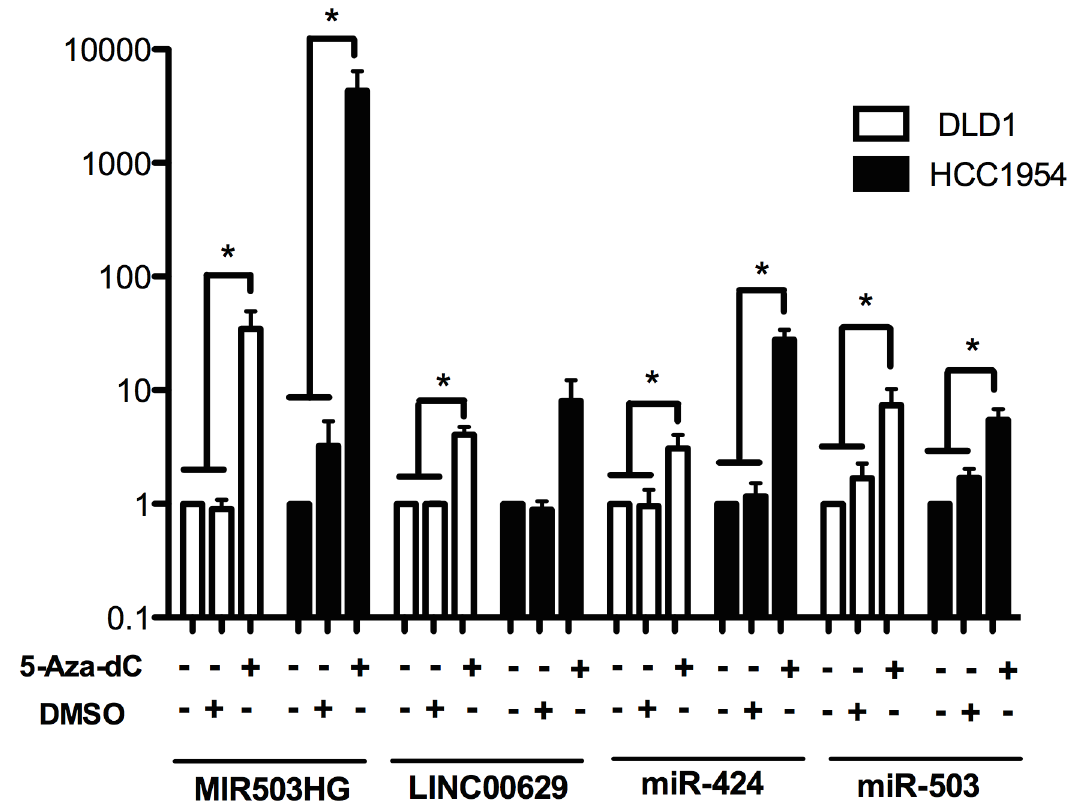
Fig 4. MIR503HG and LINC00269 expression can be regulated by methylation. Expression levels of MIR503HG , LINC00269 ,and their neighbouring miRNAs — miR-424 and miR-503, were determined in RNA samples from breast and colon adenocarcinoma cell lines treated with 5-aza-2-deoxycytidine (5-Aza- dC) by RT-qPCR normalizedto the geometric mean from GAPDH and HPRT genes (for MIR503HG and LINC0026 genes) or snoRNAs RNU24 and RNU48 (for miRNAs). Relative expression was obtained from three independent experiments using samples without treatment as reference samples (2 - ΔΔ CT ). * p < 0.05 ( t